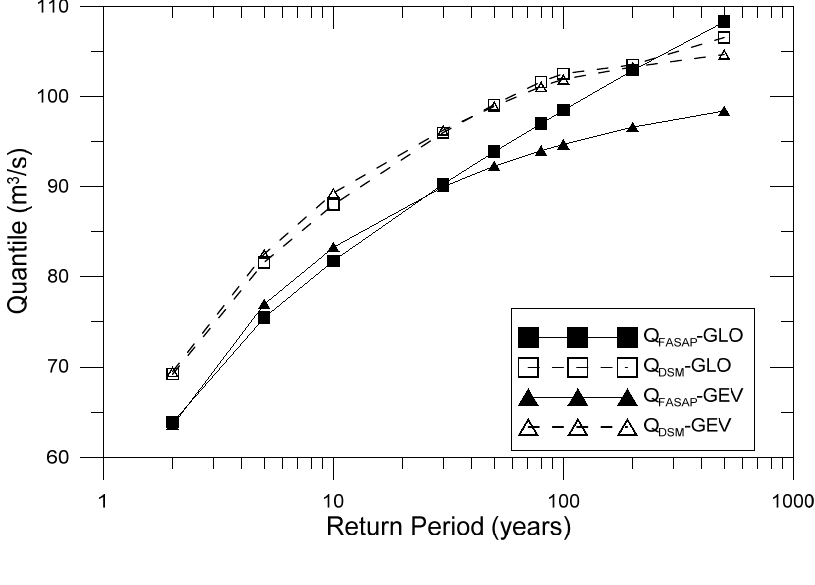
Figure 13. The estimated flood quantiles of design storm method and FASAP.